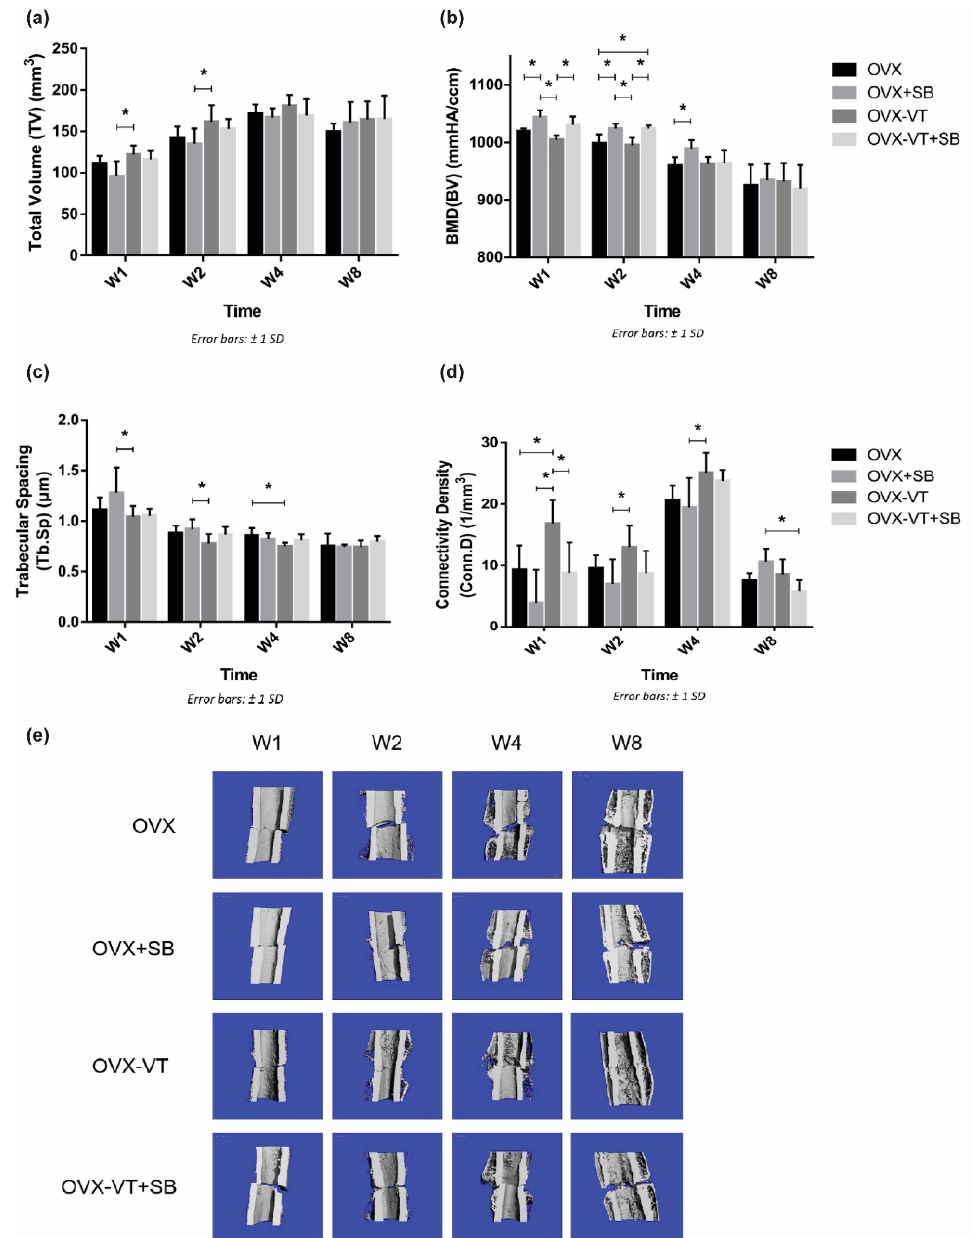
Figure 4. MicroCT evaluation of fracture site. ( a ) Tissue volume (TV) was shown to be enhanced by the vibration treatment at weeks 1 and 2 compared to other groups. ( b ) Segmented Bone volume (BV) was found to be enhanced by the VT at weeks 1 and 2, and the enhancement effects were abolished when p-38 was inhibited with a specific inhibitor. ( c ) Trabecular spacing (Tb.Sp) was lower in the vibration treated group from week 1 to 4. ( d ) Connectivity density (Conn.D) was found to be higher in the vibration treated group from weeks 1 to 4, and p-38 inhibition removed all treatment effects. ( e ) Representative microCT 3D-reconstructed images showing all groups at each end-point. * Statistical significance considered at p < 0.05, one-way ANOVA with post-hoc Bonferroni test. Abbreviation: W: week.